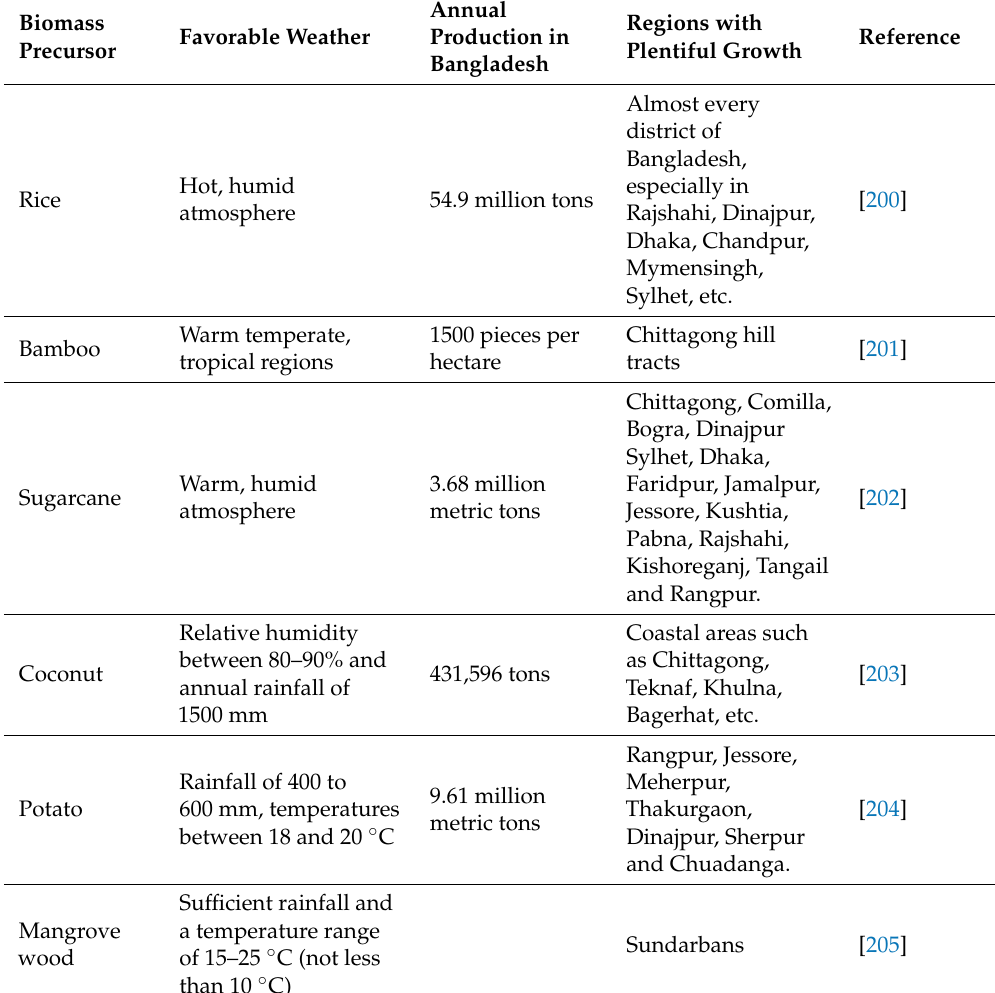
Table 5. Favorable weather conditions, annual production and availability of biomass precursors in